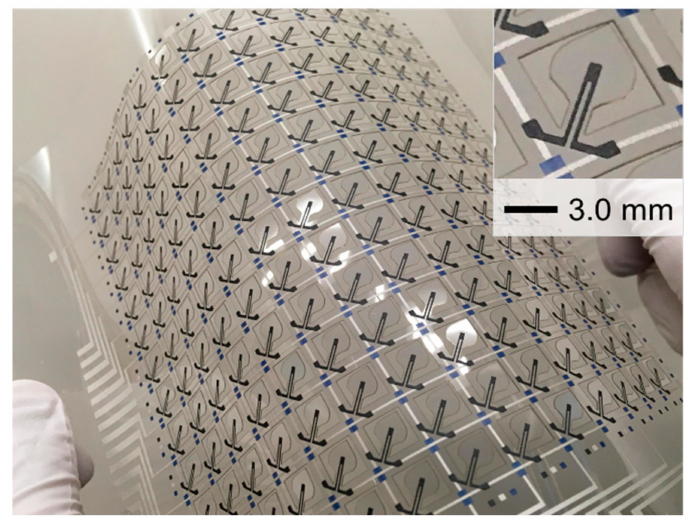
Figure 5. Appearance of the wind pressure distribution sensor sheet fabricated in this